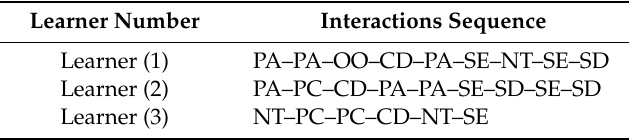
Table 7. FCS learners’ interactions sequence.